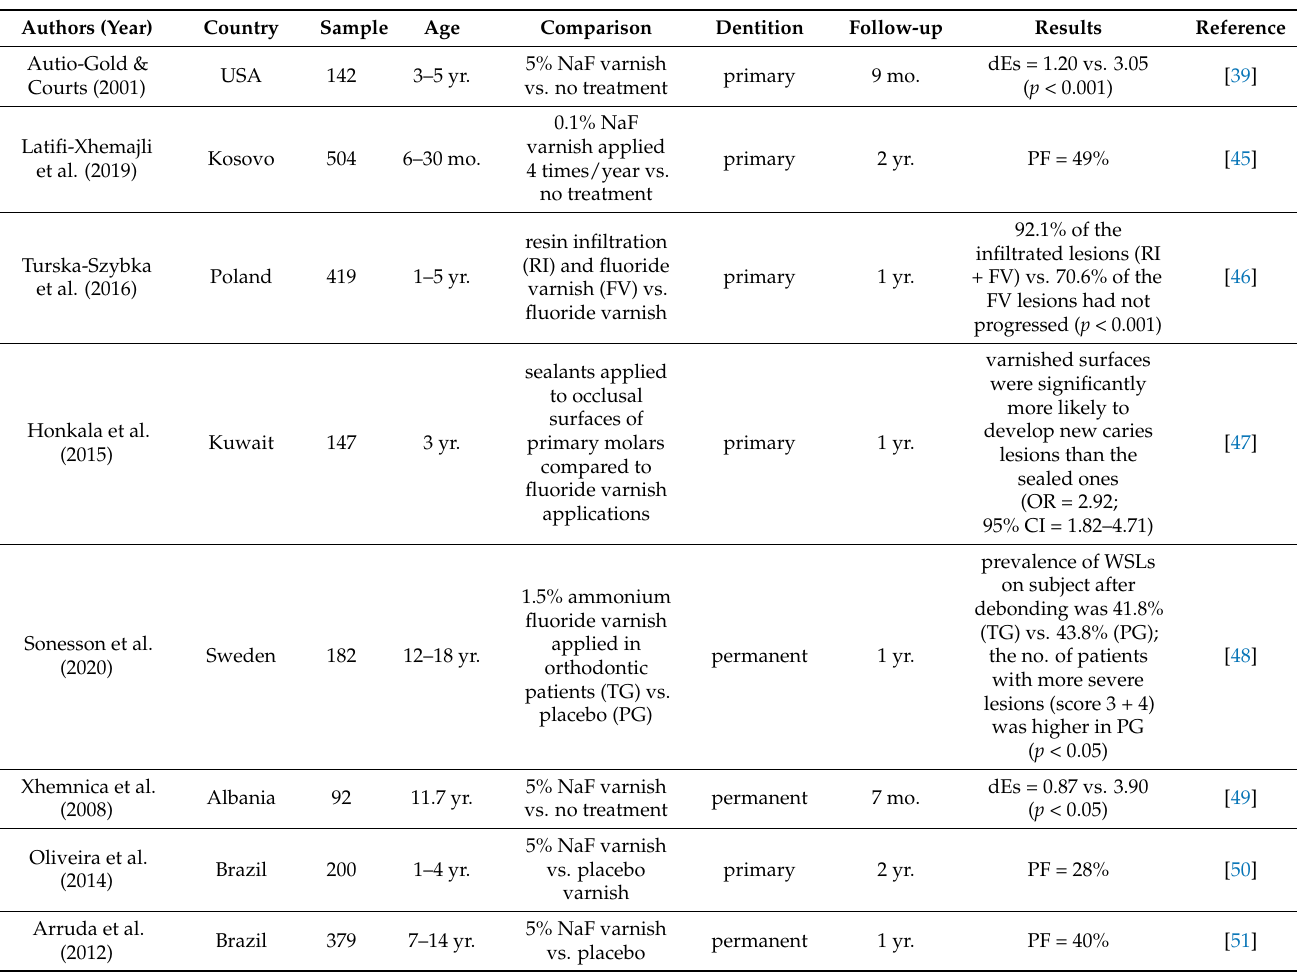
Table 2. Comparative data about professionally applied fluoride varnishes in